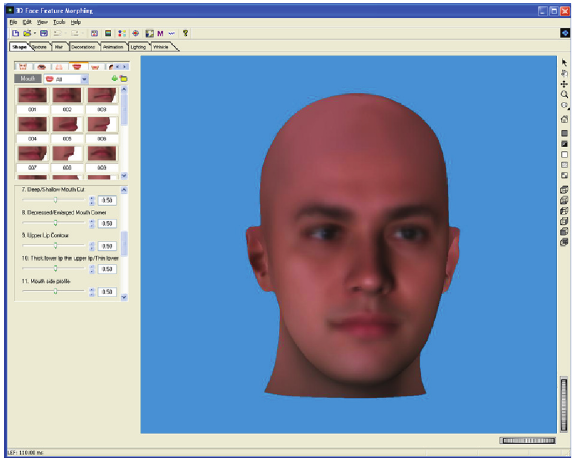
Figure 9: GUI of our system. Table 2: Details of the data used in our system. M is the number of examples, N is the number of mesh vertices (the number of original dimensions equals 3 N ), K is the number of reduced dimensions of the PCA space, and m is the number of anthropometric control